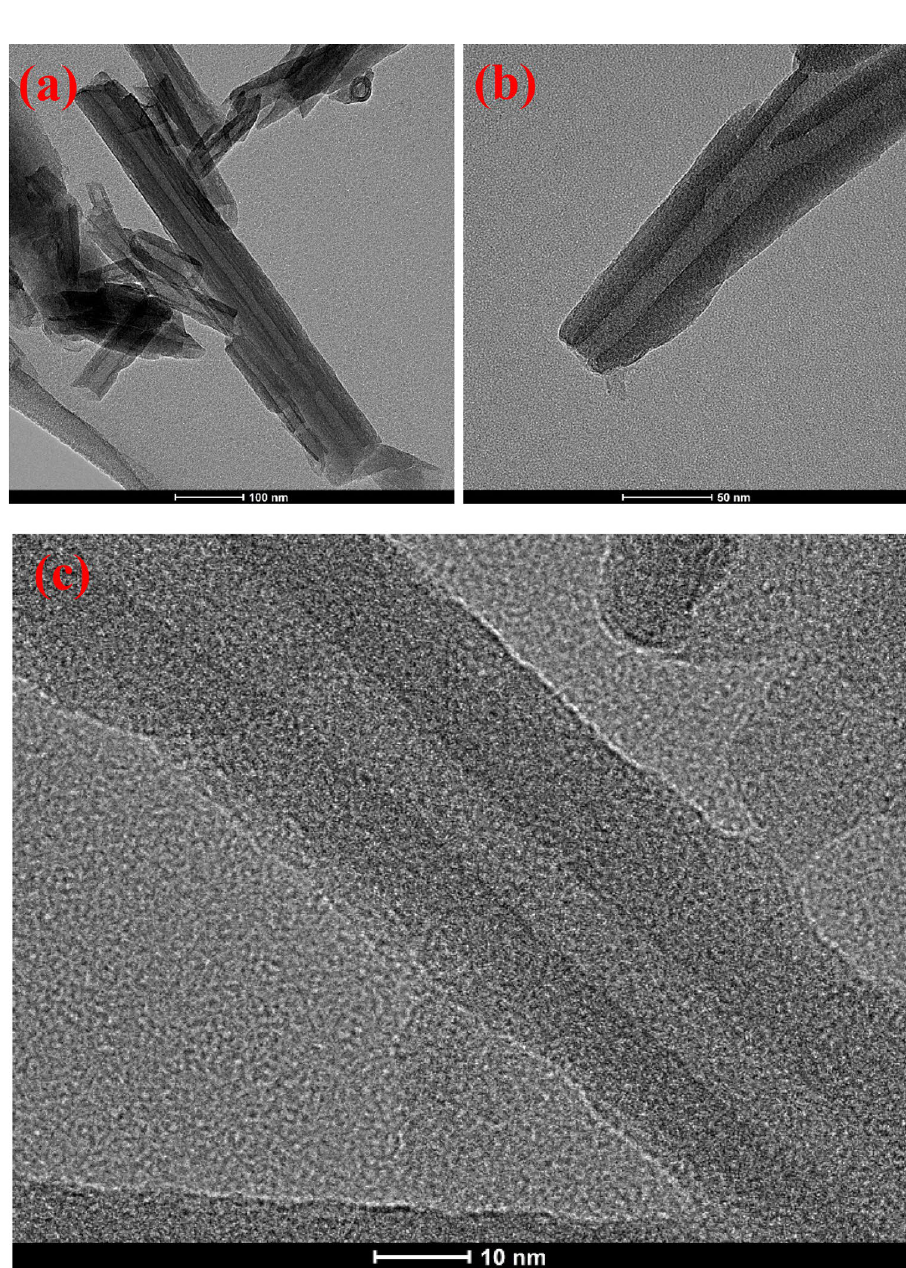
Figure 3. TEM images of raw HNTs before functionalization.